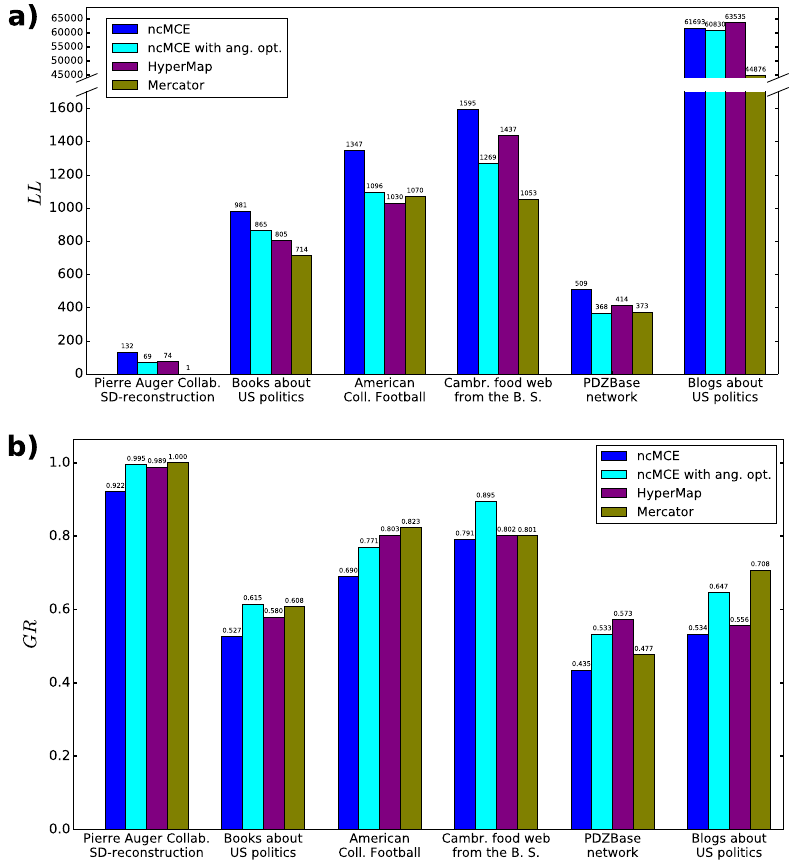
Figure 5. Embedding results for real networks. ( a ) The logarithmic loss for the original ncMCE (blue), ncMCE with angular optimisation (cyan), HyperMap (purple) and Mercator (olive) for the real networks that we studied. ( b ) The greedy routing score for the same